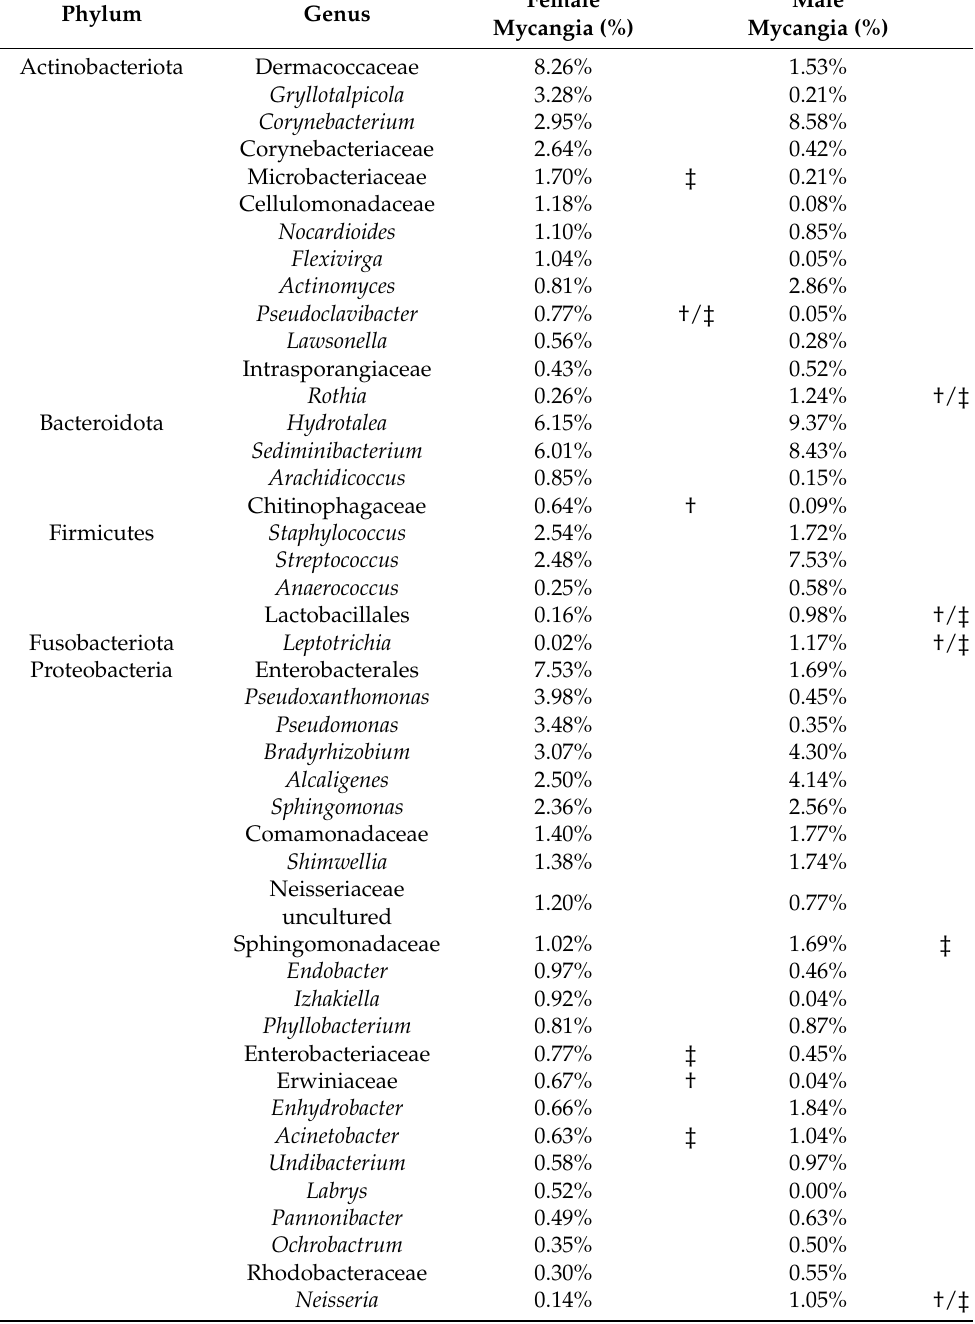
Table 1. Shared genera between the mycangia of female and male beetles of P. cylindrus . Identity of the genera (order or family if not further classifiable) and their relative abundances with a minimum of 0.5% within at least one sex are